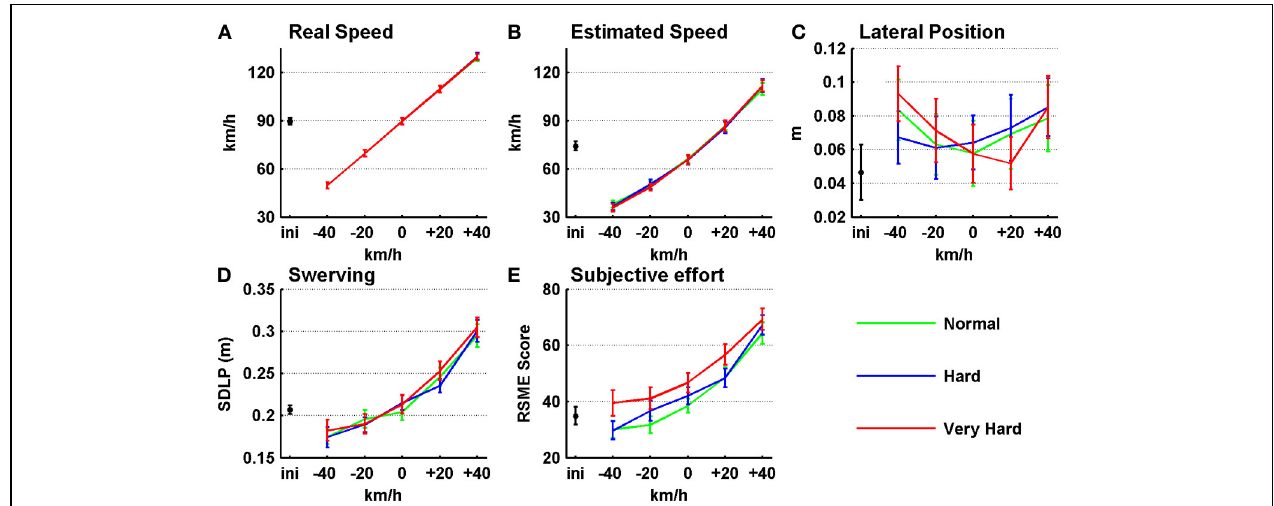
FIGURE 1 | Vehicle parameters and subjective ratings as a function of set driving speed condition. (A) Real driving speed. (B) Estimated driving speed. (C) Lateral Position (LP). (D) Standard Deviation of the Lateral Position (SDLP). (E) Rating Scale Mental Effort (RSME). On the x-axes, values for the initial ride (black dots) are shown in addition to five driving speeds that were set, relative to the individual’s preferred driving speed established during the